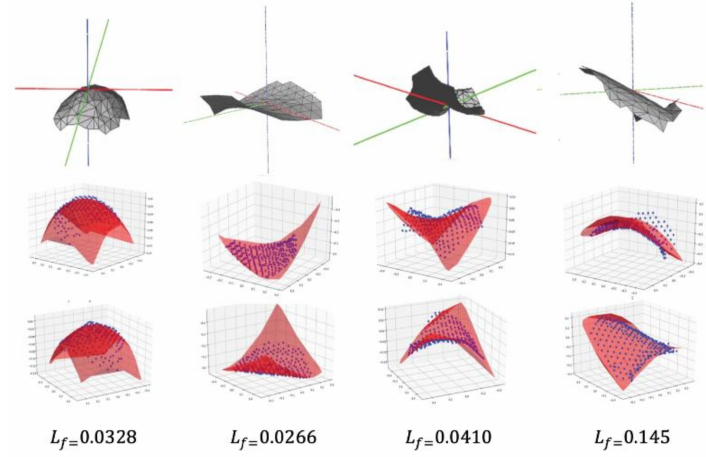
Figure 4. Mesh shape and second-order polynomial fitting.